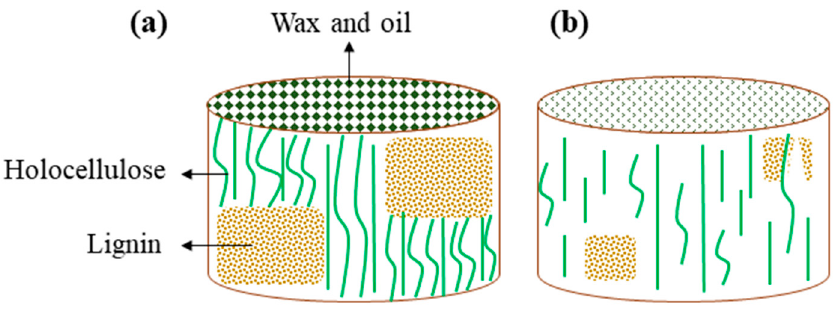
Figure 4. Structure of natural fibers ( a ) before and ( b ) after alkaline treatment.